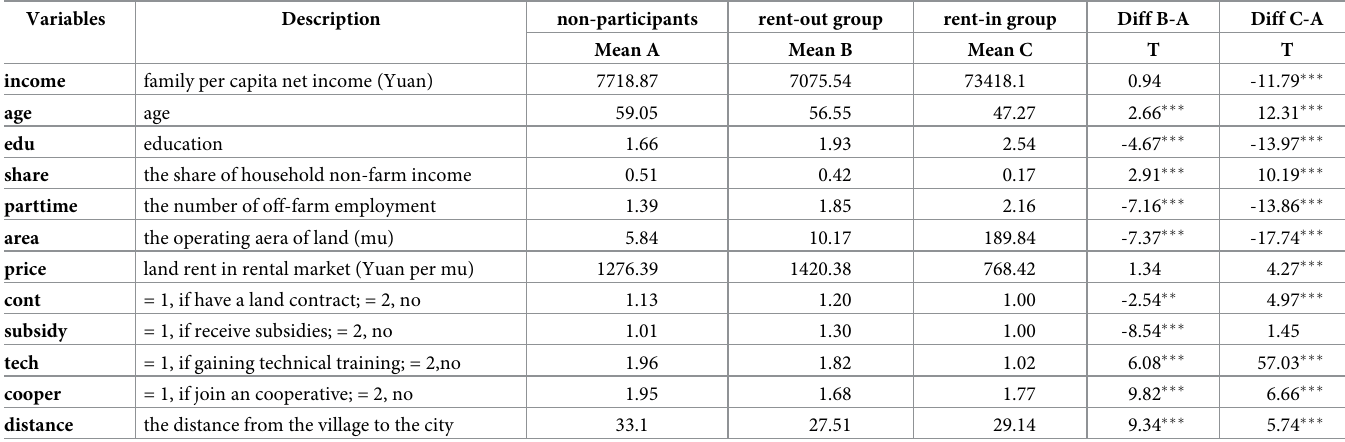
Table 2. Descriptive statistics of variables in the